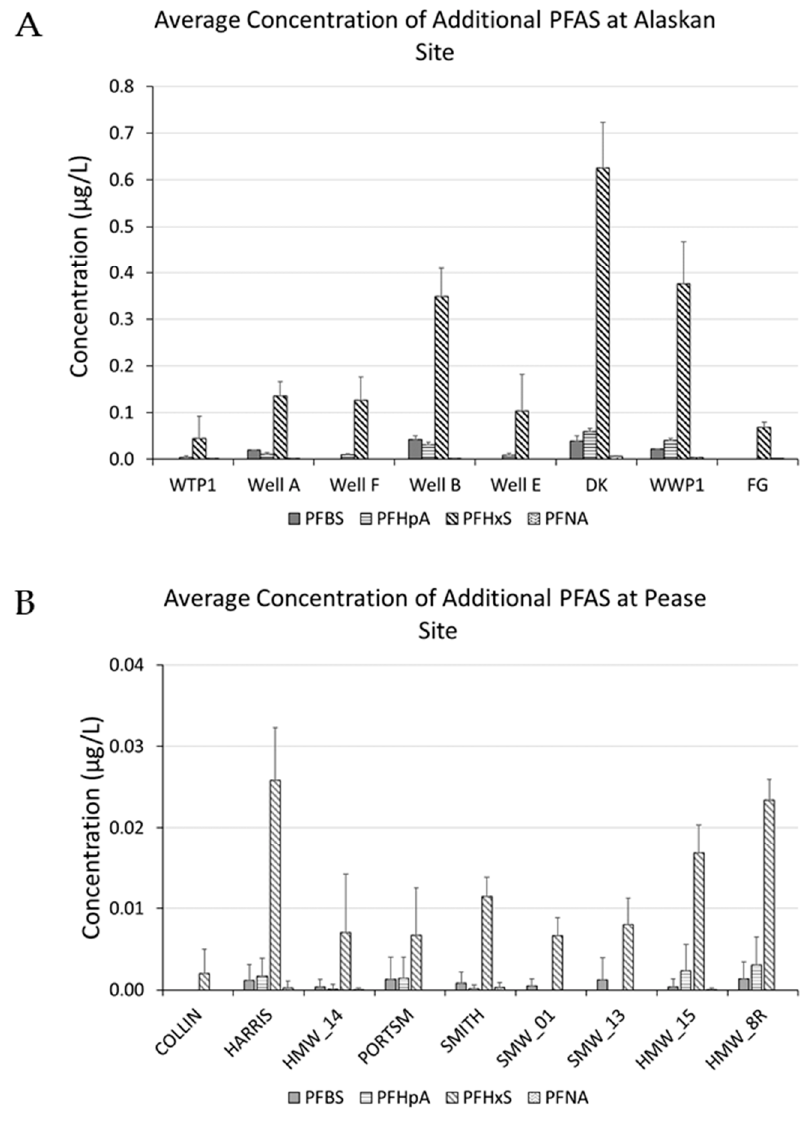
Figure 3. The above chart shows the average and standard deviation in additionally sampled polyfluoroalkyl substances (PFAS) concentrations during the same time frame. ( A ) Alaska military base; ( B ) Pease AFB. Missing data were excluded from the plots. Because of the numerous data points for the Pease data, only wells that consistently had positive identification of the PFAS are shown. PFBS, perfluorobutanesulfonic acid; PFHpA, perfluoroheptanoic acid; PFHxS, perfluorohexane sulfonic acid; PFNA, perfluorononanoic acid.